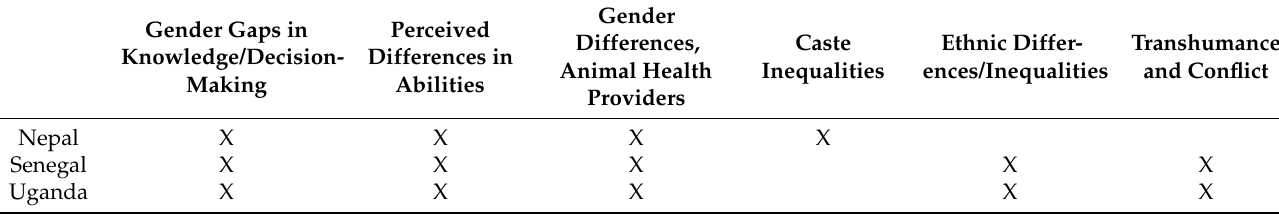
Table 2. Themes identified in qualitative analysis, by